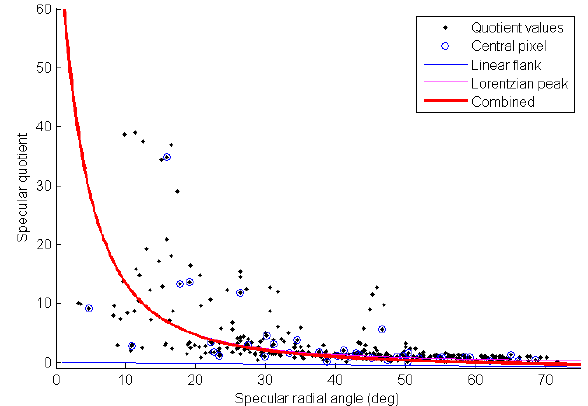
Figure 17. Lorentzian peak and linear flank functions fitted to distribution of specular quotient values.